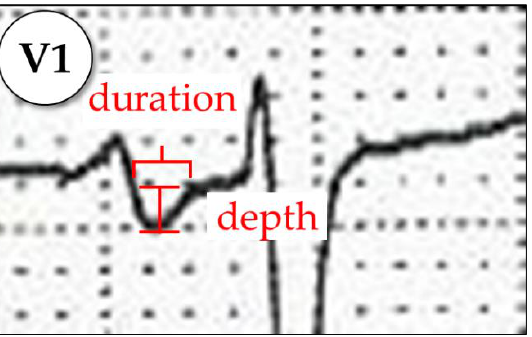
Figure A4. P-wave Terminal Force in V1 equals the product of negative deflection duration × depth.